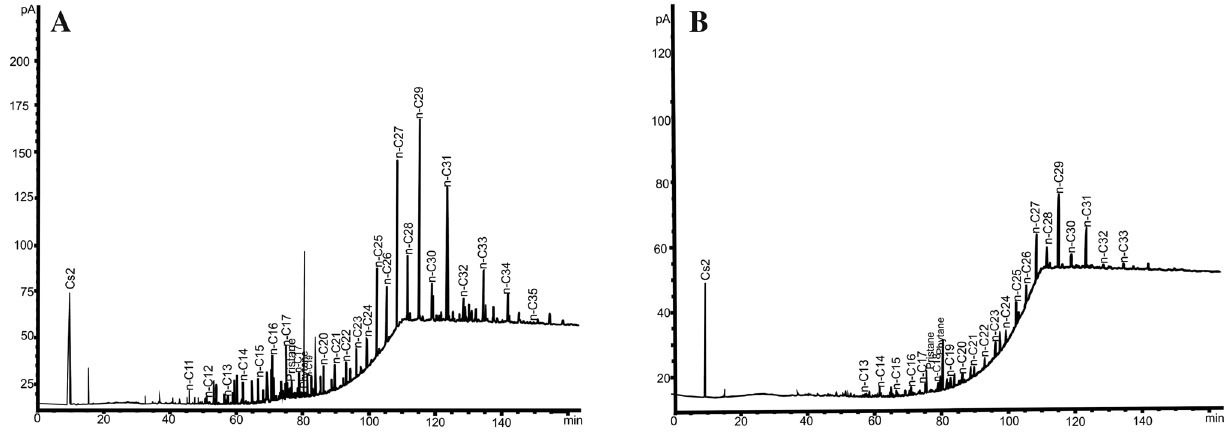
Fig. 8 Gas chromatograms for the whole extract from the shale samples and humic coal from Turabi and Halıkışlak formation, a Turabi and b Halıkışlak formation’s samples